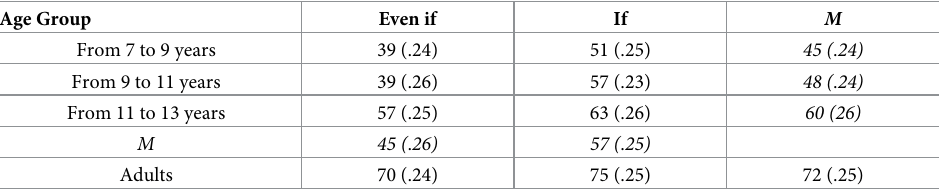
Table 3. Percentage of correct responses in epistemic status in Studies 1 with adults and 2 with children.